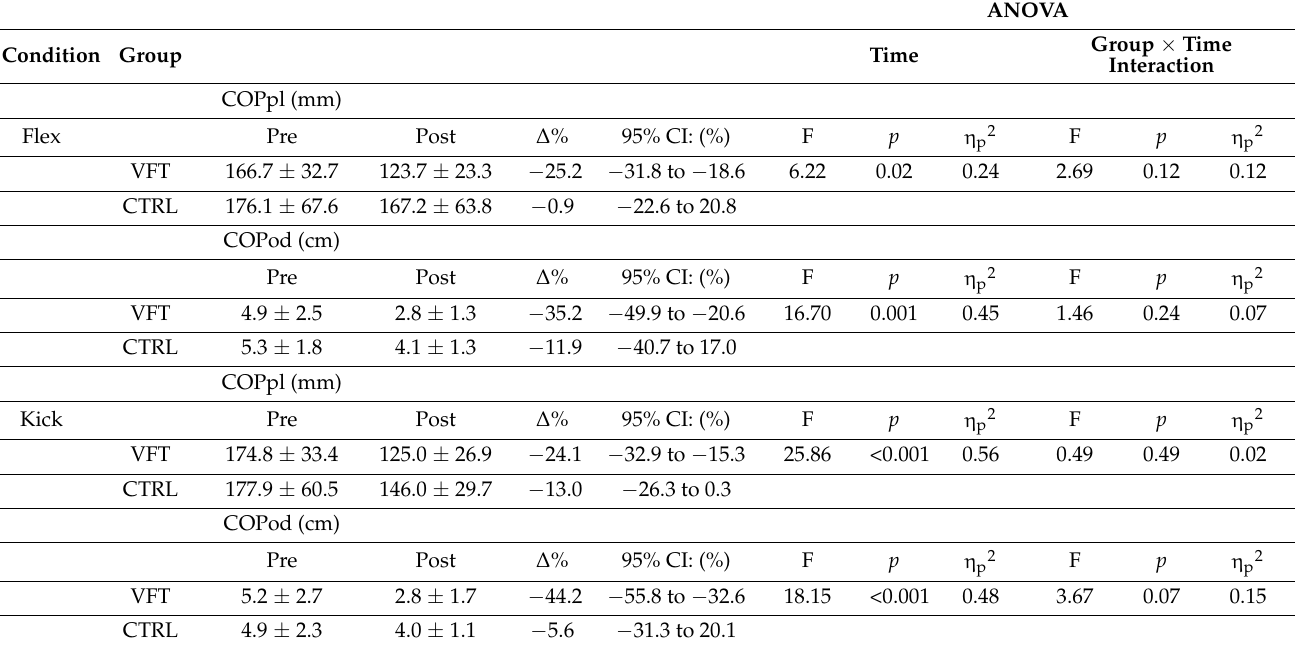
Values are expressed as mean ± SD for the visual feedback training (VFT) and control group (CTRL). Flex: knee (~155 ◦ ) of the supporting leg slightly bent, flexed hip and knee of the kicking leg; Kick: knee (~155 ◦ ) of the supporting leg slightly bent, mawashi-geri posture for the kicking leg; COPpl: center of pressure path length; COPod: center of pressure distance from origin; ∆ %: percentage difference between Pre- and Post-training; 95% CI: (%): 95% confidence interval of the Pre–Post percentage difference; η p2 : partial